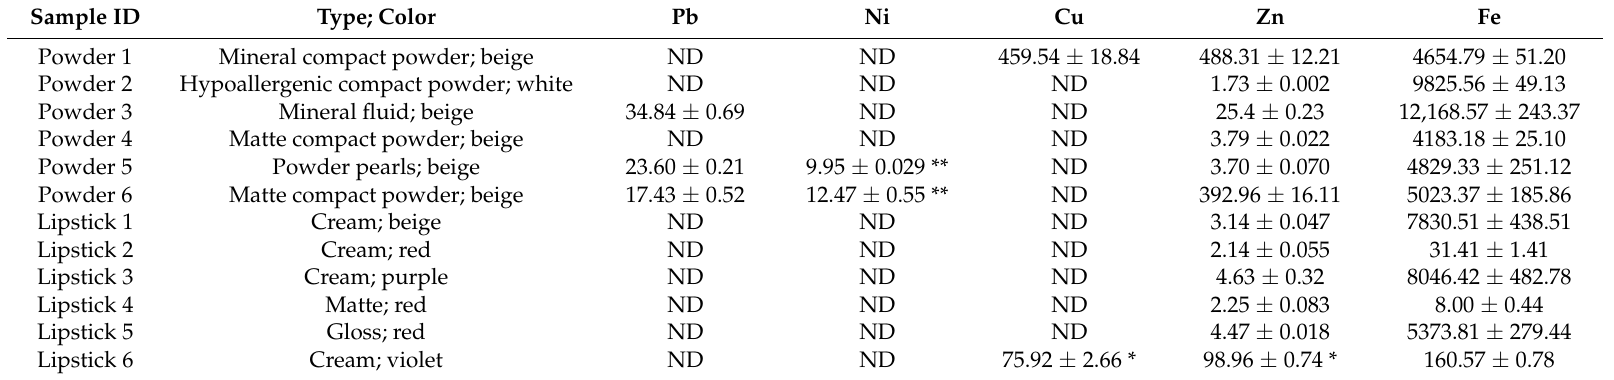
Table 2. Descriptive statistical summary of heavy metal concentration (mean ± SD) in different cosmetic products in mg/kg (ND = not detectable) ( p < 0.05) (* p < 0.01; ** p <